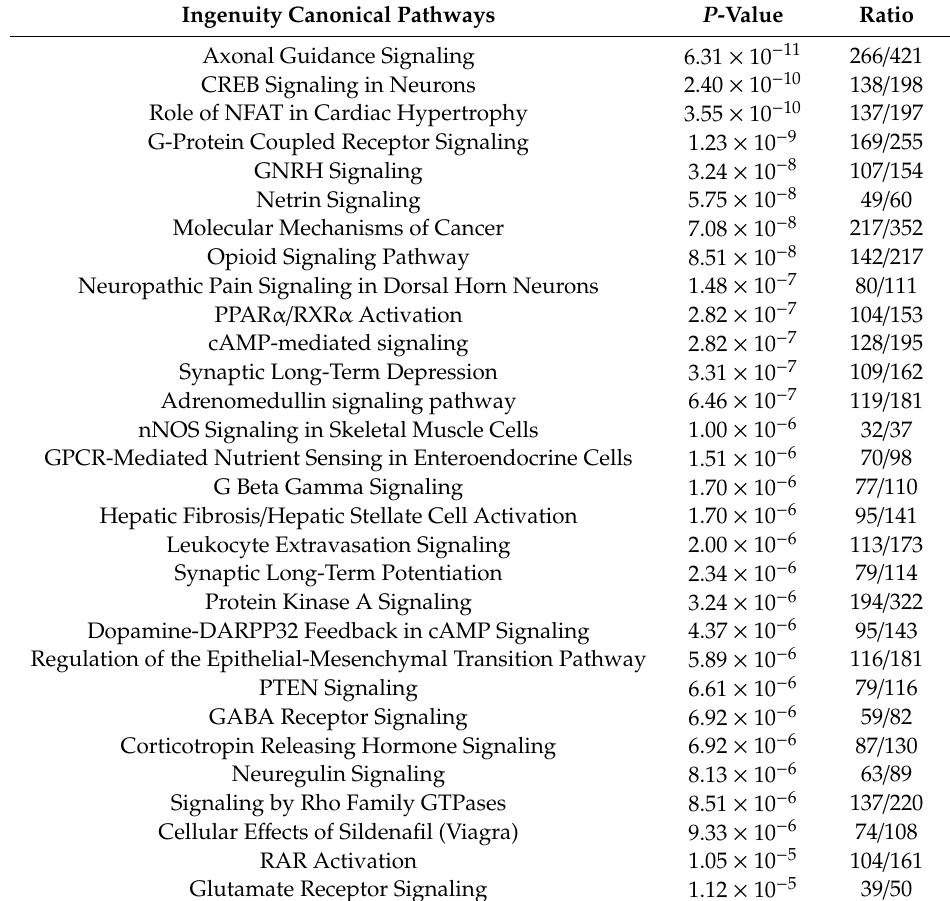
Table 2. Top 30 most significantly enriched canonical pathways associated with genes that are di ff erentially methylated in the liver of age-2 compared to age-1 males. Ratio column indicates number of a ff ected genes over the total genes in the